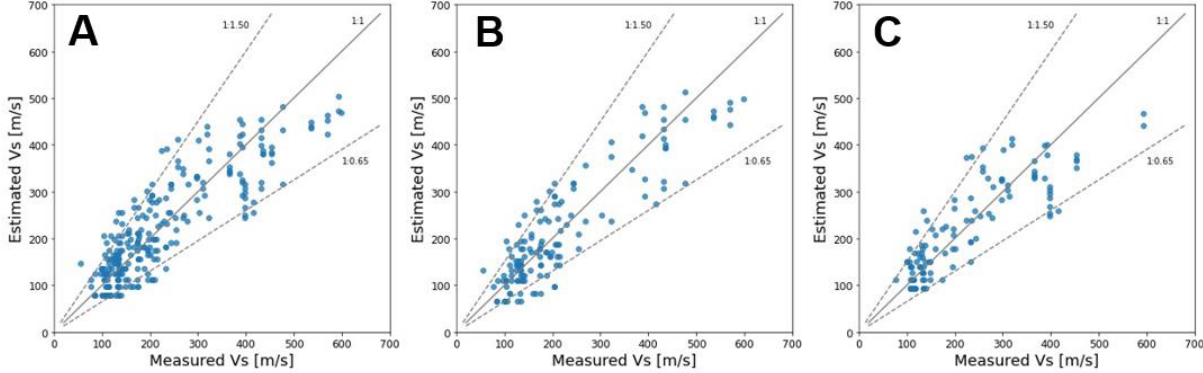
Figure 8. Measured versus estimated V s for ( A ) all soils, ( B ) sandy soils, and ( C ) clayey soils with lines of 1:1.5, 1:1 and 1:0.65.